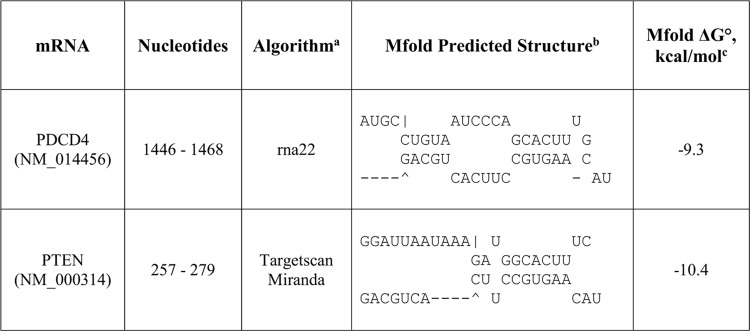
Predicted anti-miR-17-3p binding sites in the 3'UTR of PDCD4 and PTEN mRNAs as a mimic of miR-17-5p passenger strand.
aThe potential oncomiR:mRNA binding sites were identified by rna22, Targetscan, or miRanda. bTop strand is mRNA (5' ➔ 3') and the bottom strand is oncomiR (3' ➔ 5'). cCalculated at http://mfold.rna.albany.edu/?q=mfold.